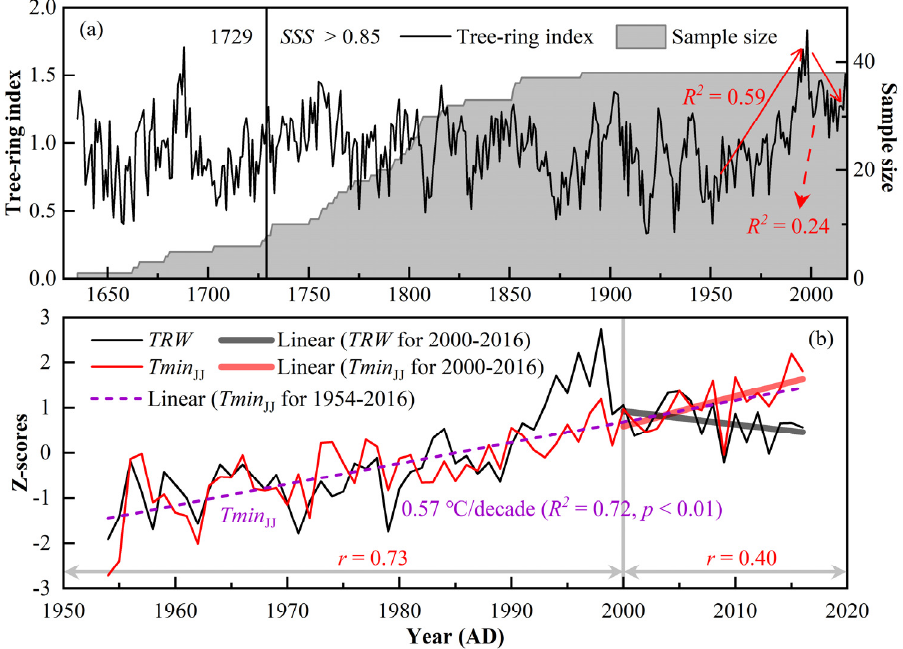
Figure 3. ( a ) TRW chronology during 1635–2018 AD and the sample size. ( b ) Comparisons between the TRW index (black line) and the mean minimum temperature from June to July ( Tmin JJ , red line) during 1954–2016 AD.